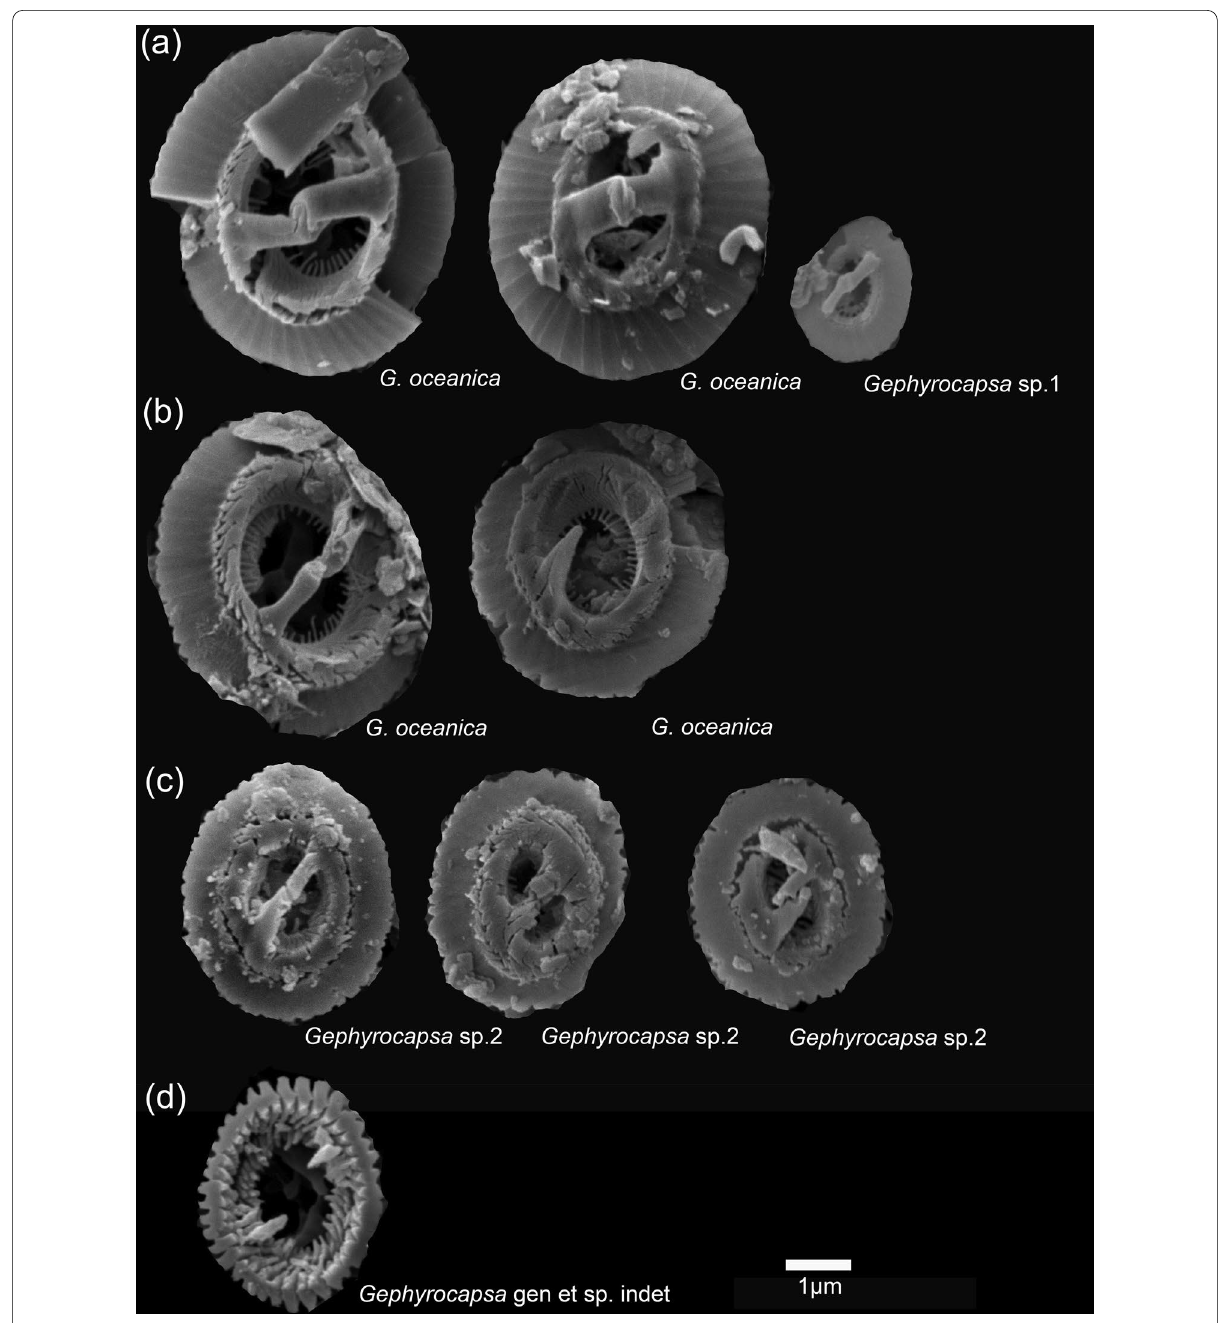
Fig. 4 SEM images of Gephyrocapsa spp. obtained from core GS-UR-1. a G. oceanica and Gephyrocapsa sp. 1 obtained from a sample collected at a depth of 29.20–29.22 m in the Kioroshi Formation. b G. oceanica obtained from a sample collected at a depth of 52.78–52.80 m in the Kamiizumi Formation. c Gephyrocapsa sp. 2 obtained from a sample collected at a depth of 77.25–77.27 m, corresponding to the Yabu Formation. d Gephyrocapsa gen et sp. indet obtained from a sample collected at a depth of 101.7–101.9 m in the Jizodo